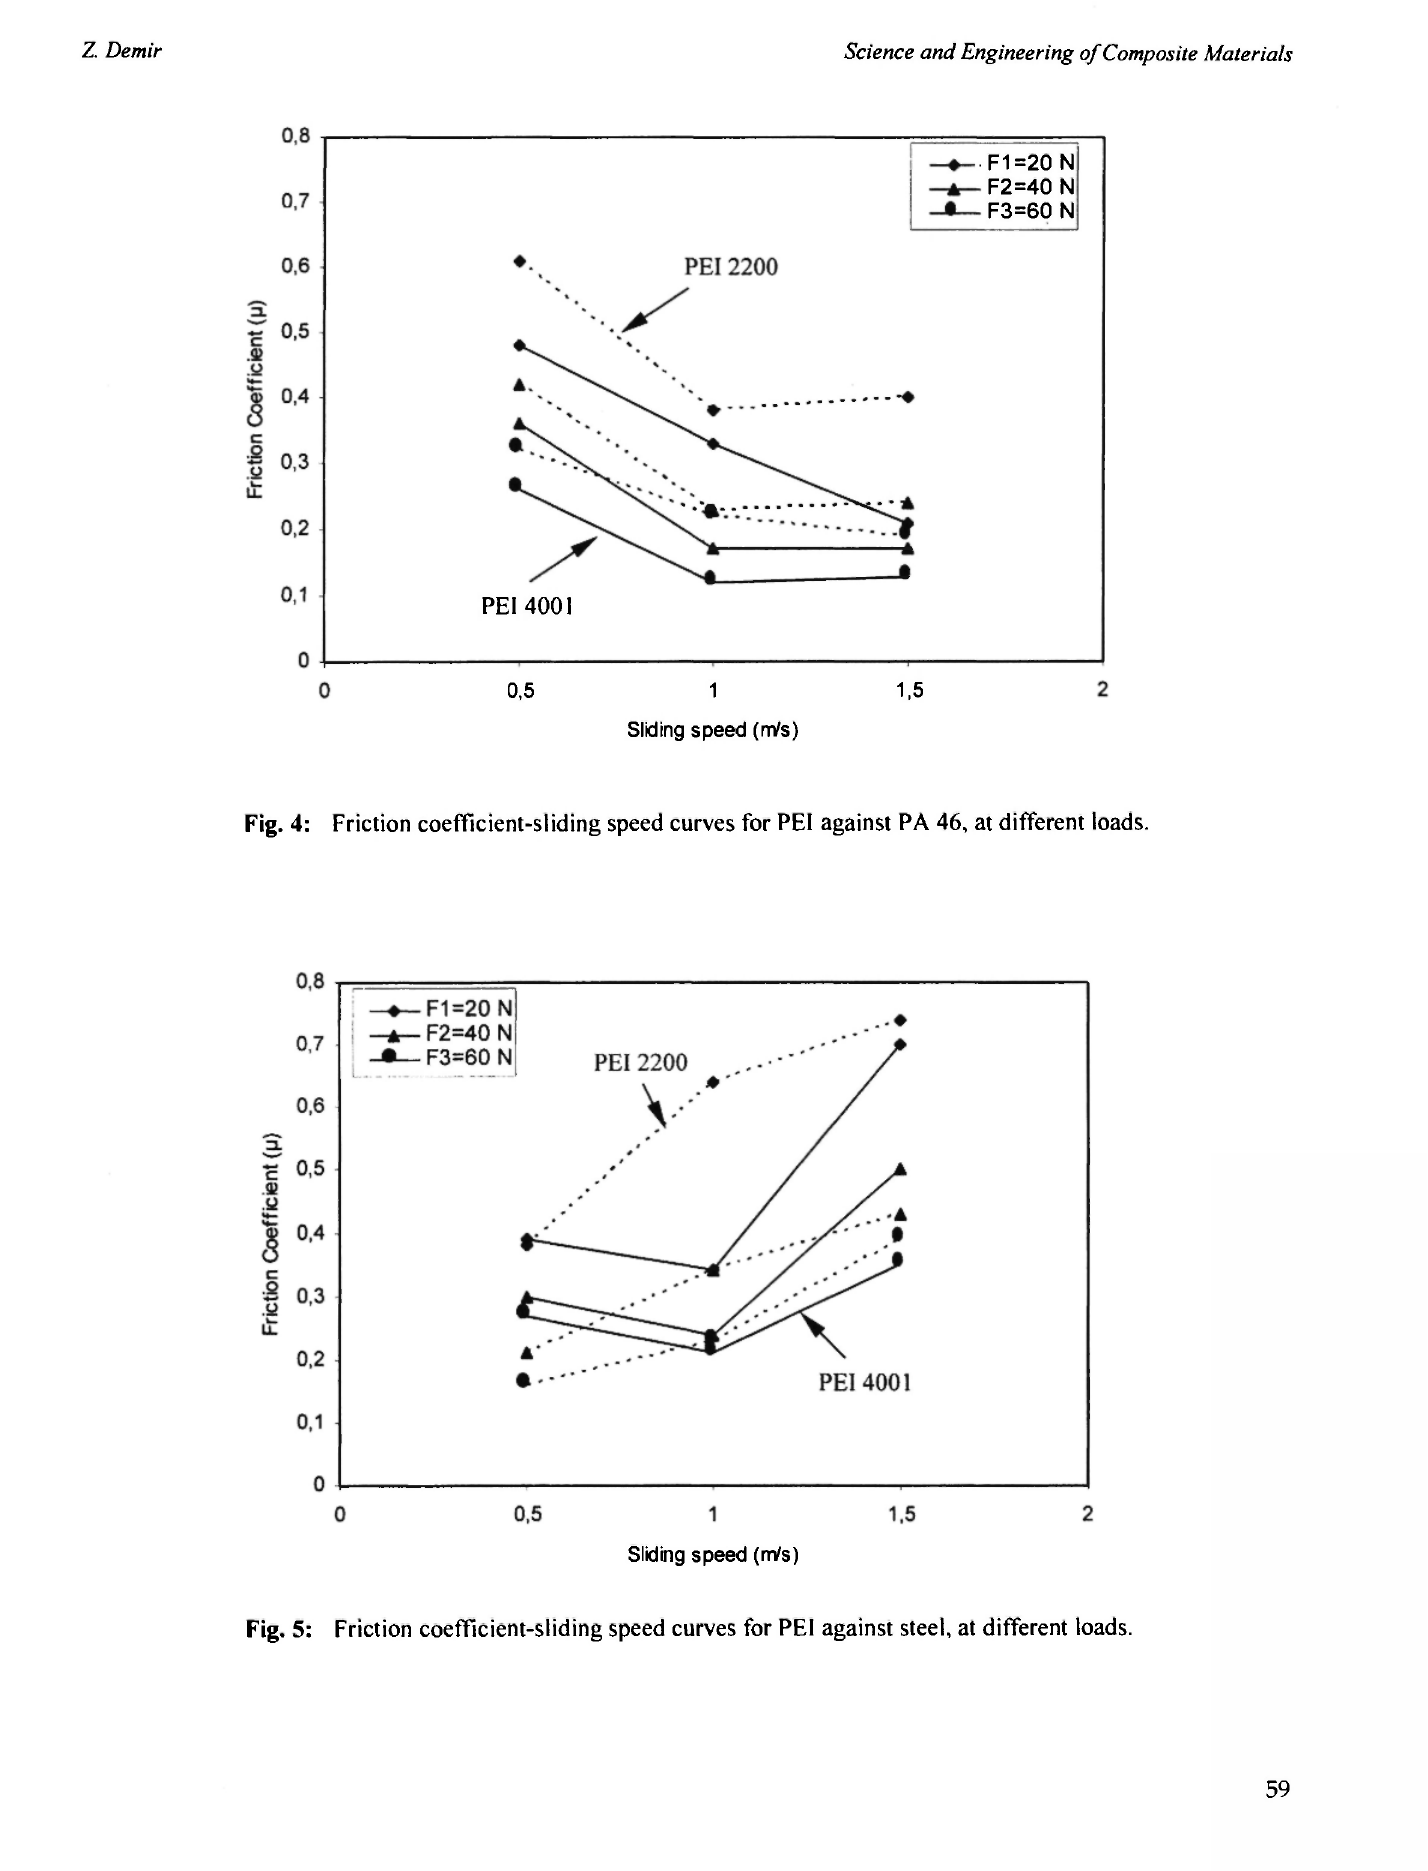
Fig. 5: Friction coefficient-sliding speed curves for PEI against steel, at different